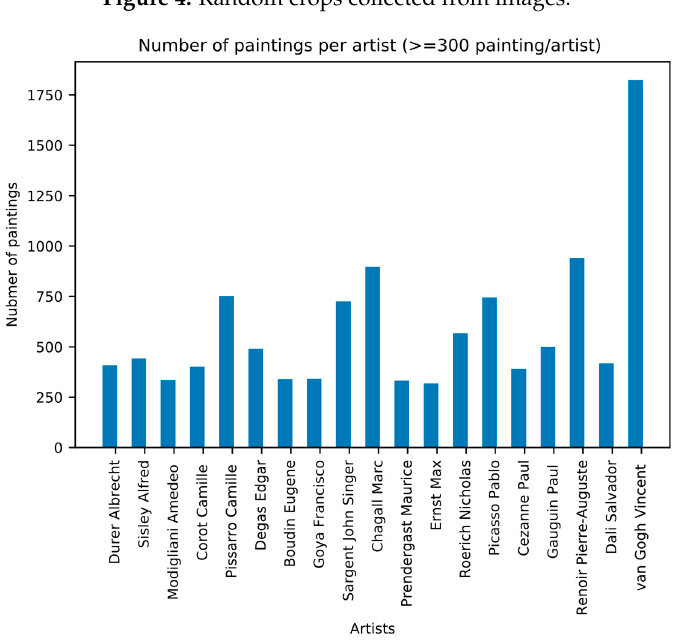
Figure 5. Distribution of paintings (number of paintings per artist).